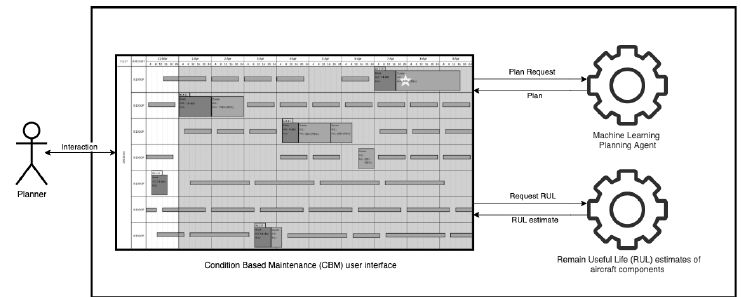
Figure 1. Condition-Based Maintenance (CBM) planning aircraft tool architecture. The user inter- acts with a Graphical User interface (GUI) that requests plans to the Reinforcement Learning (RL) automatic planning agent and requests Remaining Useful Life (RUL) visualisations for a certain com- ponent/system. Both the AutoPlan agent and the RUL visualisation obtain the historical information from the